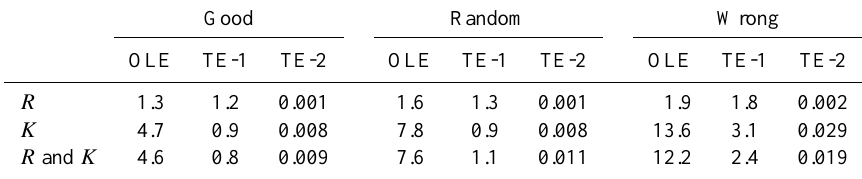
Table 3. Normalized root mean square error for the prediction period ∗ . Good Random Wrong OLE TE-1 TE-2 OLE TE-1 TE-2